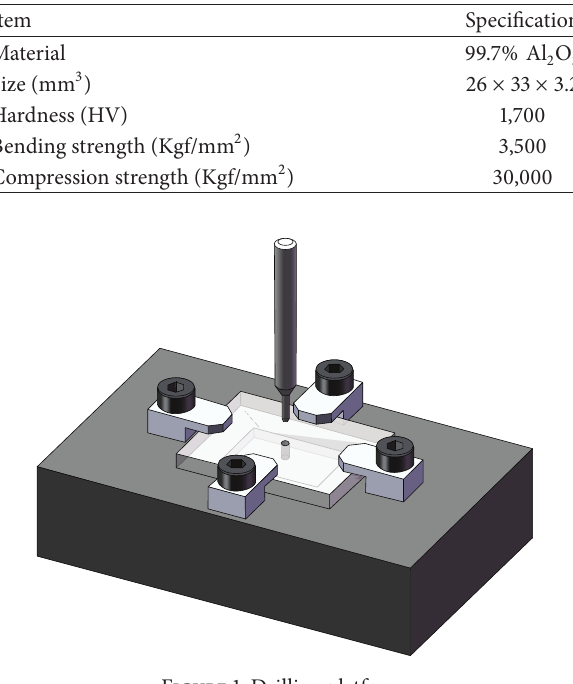
Figure 1: Drilling platform.